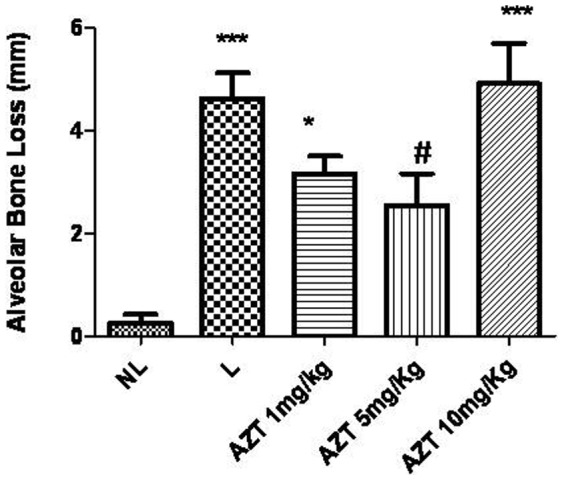
Effect of AZT treatment on alveolar bone loss associated with experimental periodontitis (EP) in rats.Values are expressed as means ±SEM (Compared to NL ***p<0.001, *p<0.05; Compared to L #p<0.05).